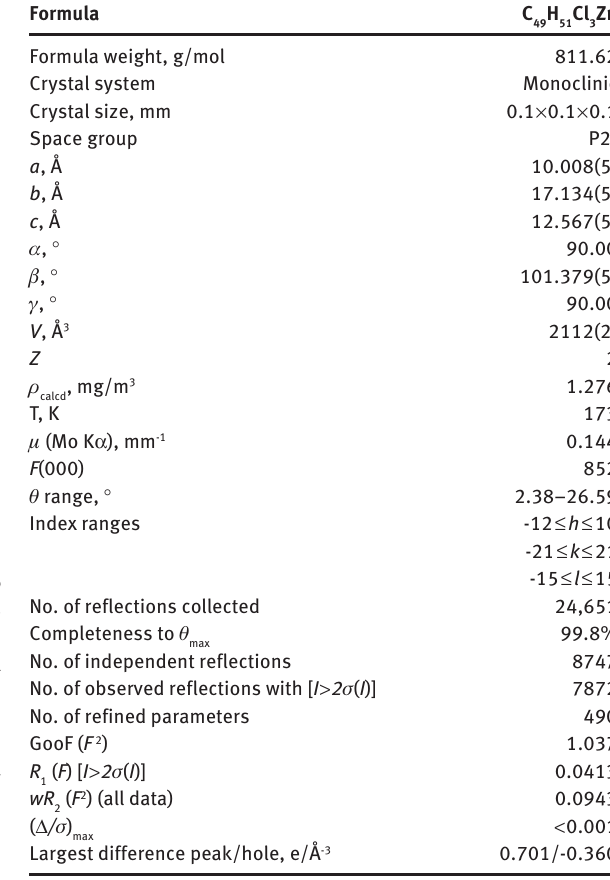
Table 2 Crystal data and structure refinement of